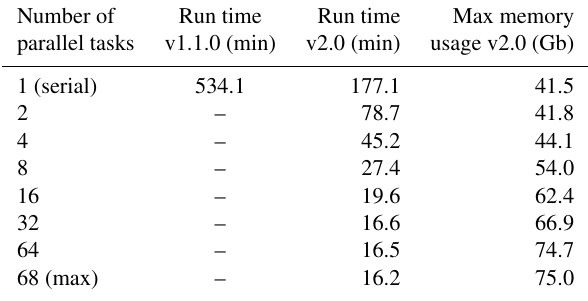
4. Times required for running recipe_perfmetrics_CMIP5.yml with ESMValTool v1.1.0 and v2.0 using different numbers of maximum parallel tasks. Note that v1.0 did not support parallelization. The corresponding maximum memory usage as diagnosed in v2.0 is also shown. Each number in this table corresponds to the median of 10 ESMValTool runs, to account for the variability in the performance across different nodes. The nodes used for this analysis feature 24 physical